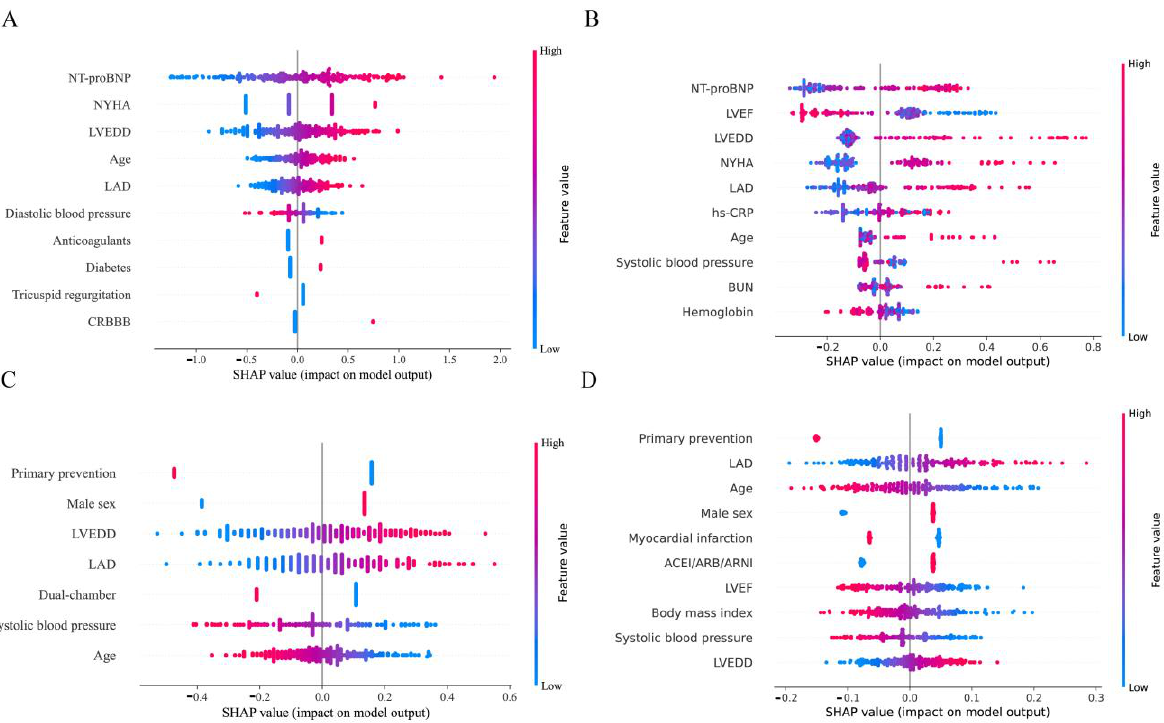
Figure 3. Model interpretability using SHAP values. CPH model ( A ), XGBoost ( B ) for prediction of death; CPH model ( C ), SSVM ( D ) for prediction of appropriate shock. The X-axis stands for SHAP value, and the predictor lies orderly on the Y-axis according to their importance (the higher in position, the more important). Only the top 10 important predictors are left in the plot. Each point on the summary plot represents a single predictor of an individual. Overlapping points are jittered in the y-axis. Red and blue colors respectively indicate higher and lower values of a predictor. For example, a high value of NT-proBNP increases the risk score of death in the CPH model predicting death. In other words, it is a risk factor. Conversely, a high value of diastolic blood pressure reduces the death risk score, making it a protective factor. SHAP, SHapley Additive exPlanations; other abbreviations as in Figure 2 and Table 1.